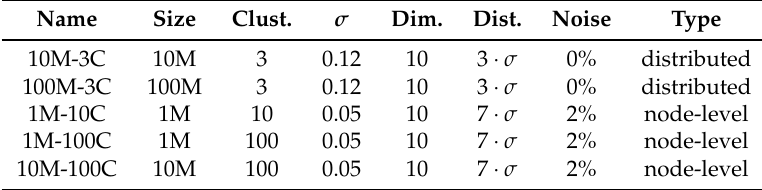
Table 3. The Gaussian datasets for the distributed and the node-level runs.